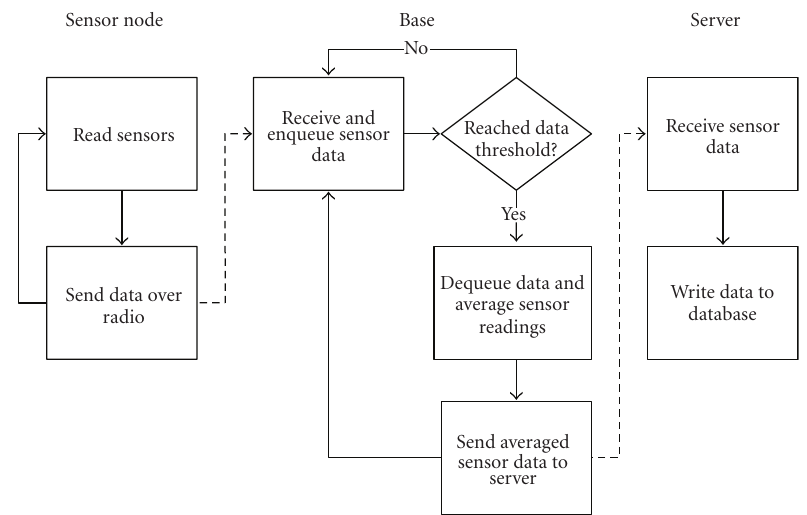
Figure 4: Flow diagram of the